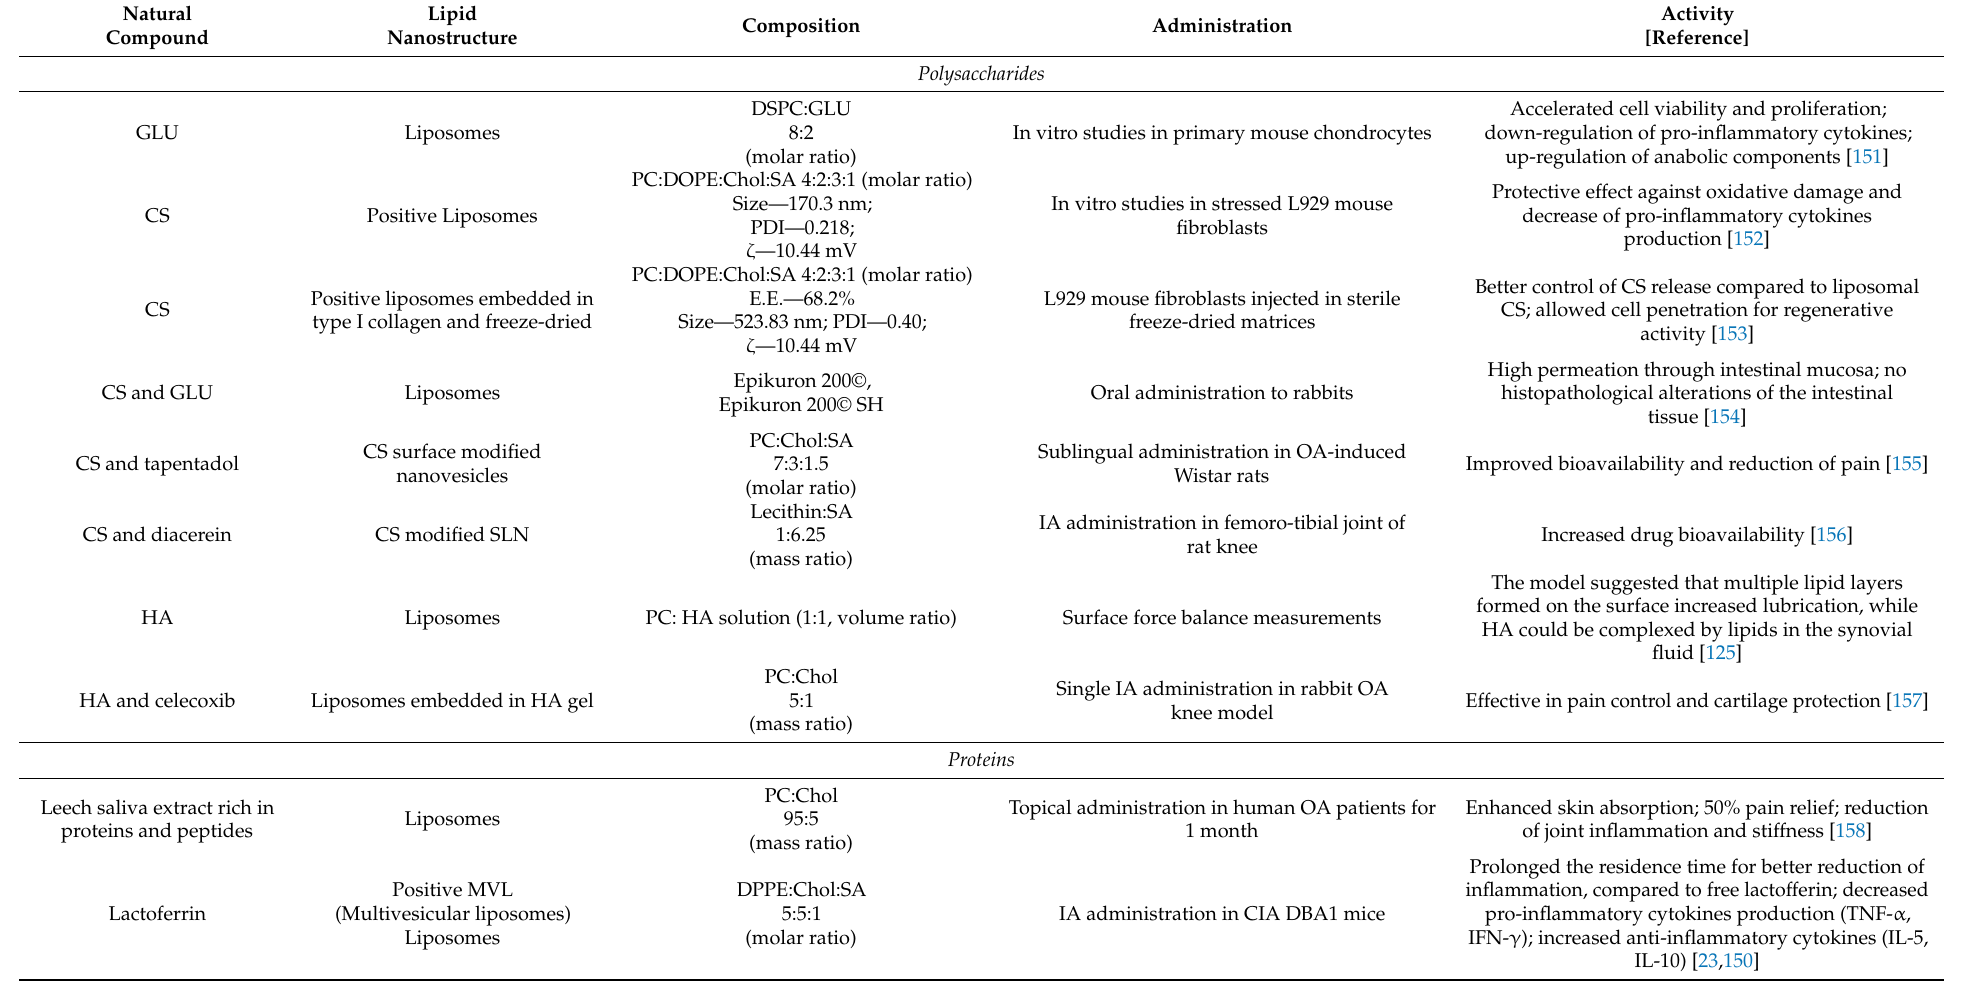
Table 2. Lipid nanostructures encapsulating natural compounds with anti-inflammatory